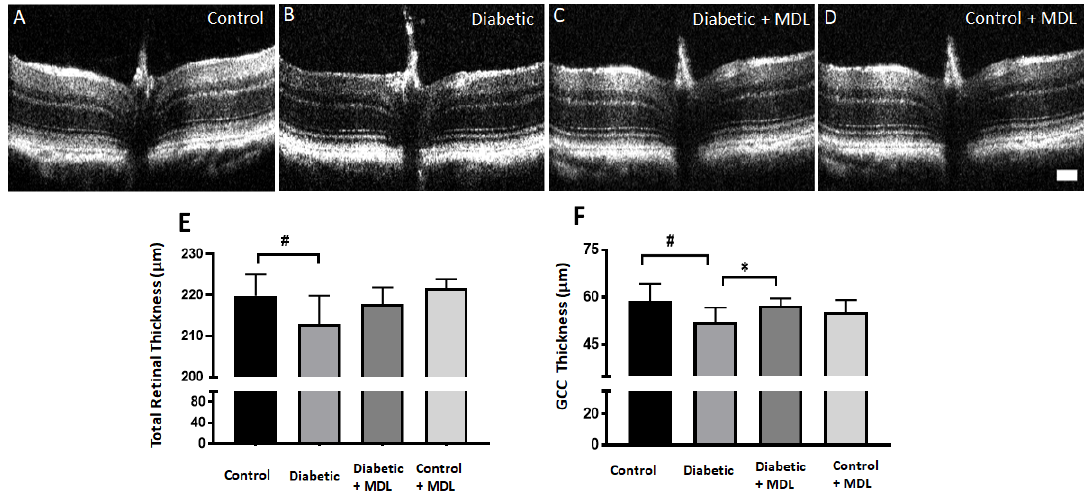
Figure 4. Analysis of diabetes-induced retinal thinning. ( A – D ) Representative images (B-scan) obtained from the spectral domain optical coherence tomography (SD-OCT) analysis of control, diabetic, MDL 72527-diabetic and MDL 72527-treated control retinas. ( E – F ) Quantification of the retinal thickness (from NFL to outer segment / RPE interface) and thickness of the ganglion cell complex (RNFL + GCL + IPL) showing a significant decrease in diabetic retinas compared to controls. MDL 72527 treatment significantly improved diabetes-induced thinning of the inner retina. Results presented as mean ± SD. N = 5–12 per group. # p < 0.01, * p < 0.05. scale bar 100 µ m.